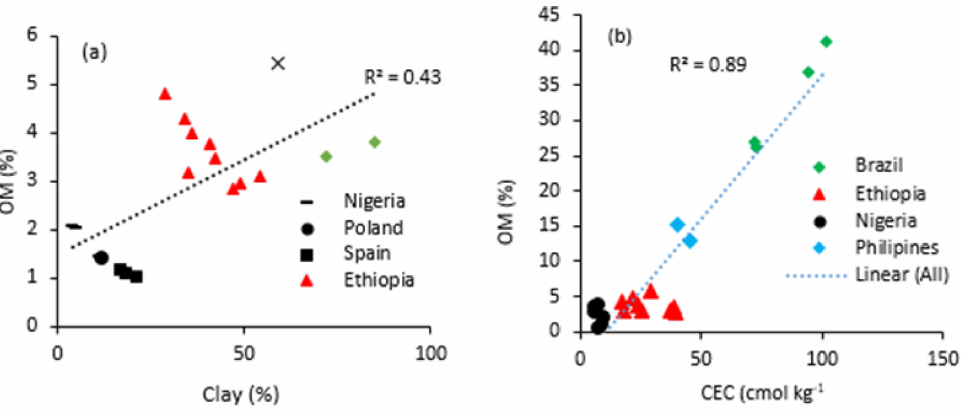
Figure 5. The relationship between Clay percent and OM percentage ( a , b ), and from various studies.